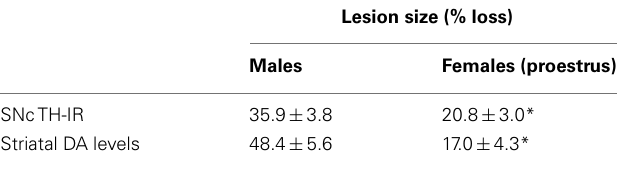
FIGURE 2 | Manipulation of the hormone environment exerts sex-specific effects on striatal lesions induced by 6-hydroxydopamine (6-OHDA). Male and female rats underwent bilateral gonadectomy (GDX) or sham operation (Gonad-intact) followed immediately, while still under anesthesia, by subcutaneous implantation of a pellet, containing either estradiol (replaced to proestrus levels), 5 α -dihydrotestosterone (to mimic physiological androgen levels), or a placebo pellet (full details in Murray et al., 2003). Approximately 1week later all animals received a unilateral infusion of 6-hydroxydopamine (6-OHDA; 1 μ g) into the left medial forebrain bundle and, after killing 2weeks later, brains were processed to assess lesion size. Results represent the percentage striatal dopamine (DA) remaining in the lesioned (left) side compared with the contralateral, unlesioned (right) side. Sham-operated animals (Gonad-intact, (cid:2) ) are taken as controls. (A) Following ovariectomy ( (cid:3) ) levels of DA in the female striatum were significantly reduced compared with their sham-operated counterparts.This effect was unaltered by treatment with the non-aromatizable androgen, dihydrotestosterone (DHT, (cid:3) ), but was reversed by estradiol (E2, (cid:3) ). (B) Following orchidectomy ( (cid:3) ), levels of DA in the male striatum were significantly greater than their sham-operated counterparts ( (cid:2) ).This effects was unaffected by treatment with DHT ( (cid:3) ), but was reversed by estradiol (E2, (cid:3) ). ∗ p < 0.05Vs. gonad-intact; # p < 0.05 vs. GDX. (Modified from Murray et al.,